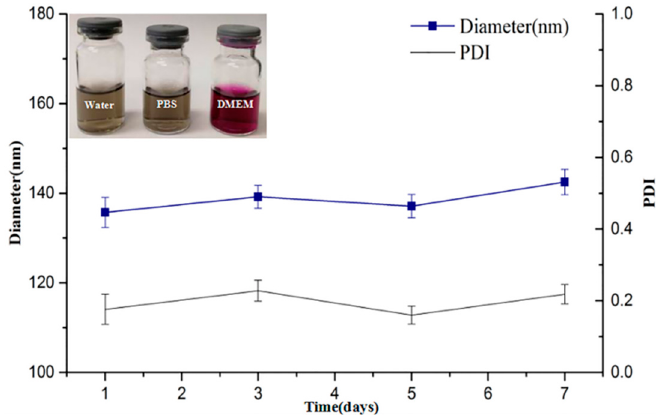
Figure 5. Dispensability, stability, particle size, and PDI (polydispersity index) diagram of GRcR. Solvent: water. Duration: seven days. The data is presented as the mean ± SD, n = 3.